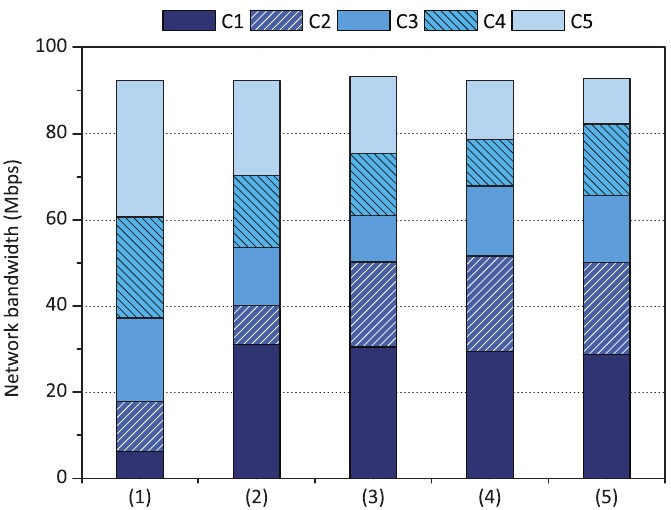
Figure 9. Minimum bandwidth reservation results of qCon when (1) proportional share scheduling was applied with weight set 1 to 5 , (2) minimum bandwidth was configured as [C1 = 30 Mbps] with weight set 1 to 5 , (3) [C1 = 30 Mbps, C2 = 20 Mbps] with weight set 1 to 5 , (4) [C1 = 30 Mbps, C2 = 20 Mbps, C3 = 15 Mbps] with weight set 1 to 5 , and (5) [C1 = 30 Mbps, C2 = 20 Mbps, C3 and C4 = 15 Mbps] with weight set 1 to 5